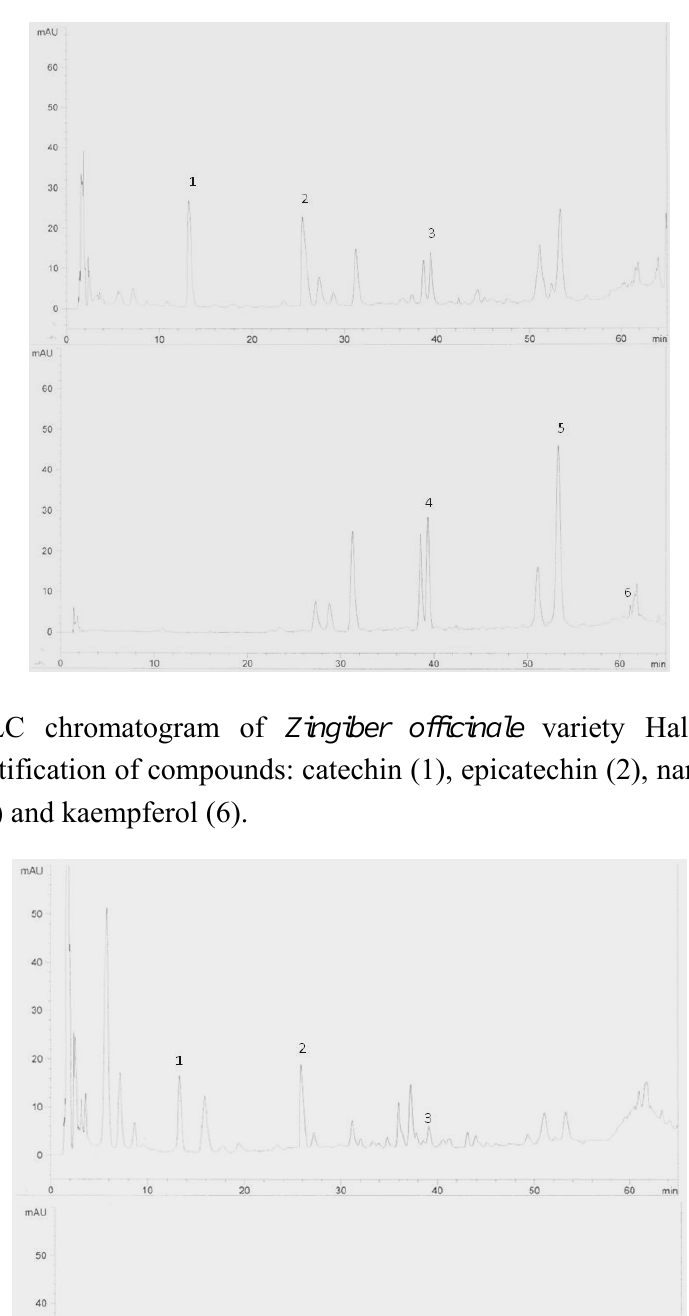
Figure 1. HPLC chromatogram of Zingiber officinale variety Halia Bara extracts (leaves). Identification of compounds: catechin (1), epicatechin (2), naringenin (3), rutin (4), quercetin (5) and kaempferol (6).